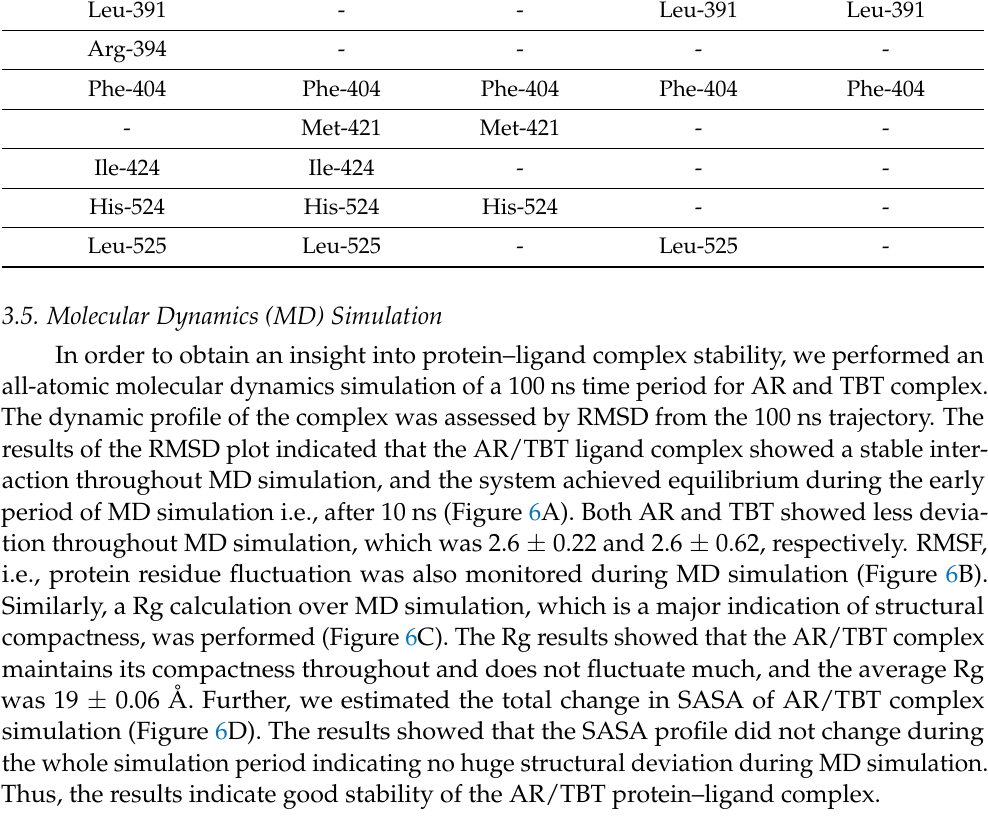
Table 4. Comparative list of amino acid residues of estrogen receptor β interacting with bound native ligand (estradiol), tributyltin, dibutyltin, diphenyltin, and monophenyltin. Residues within a row among native ligand and organotin ligands are overlapping interacting residues for the compounds. Native (Estradiol)